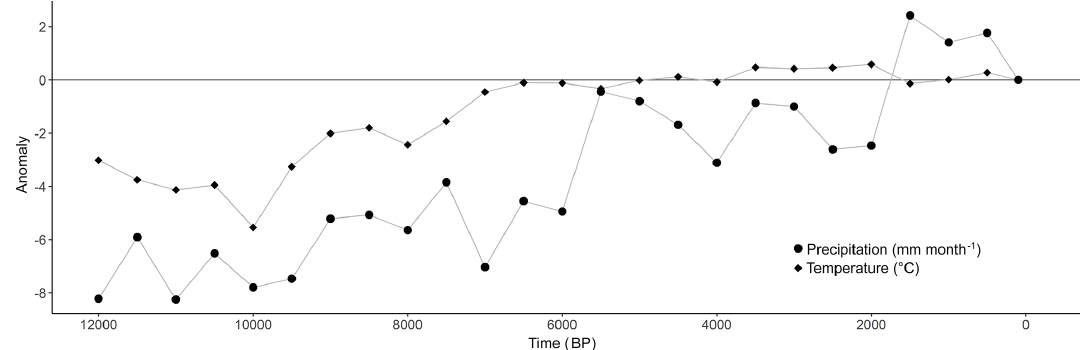
Figure 3. Reconstructed mean annual temperature ( ◦ C) and mean monthly precipitation (mm month − 1 ) anomalies for the period 12kyr– 100BP with a 500-year interval for the location of Braemar. Values extracted from a gridded European dataset with a spatial resolution of 1 ◦ × 1 ◦ (Mauri et al.,